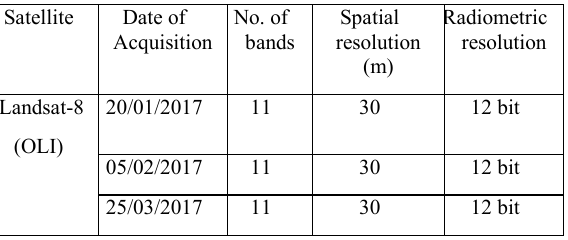
Table1. Optical satellite data specifications